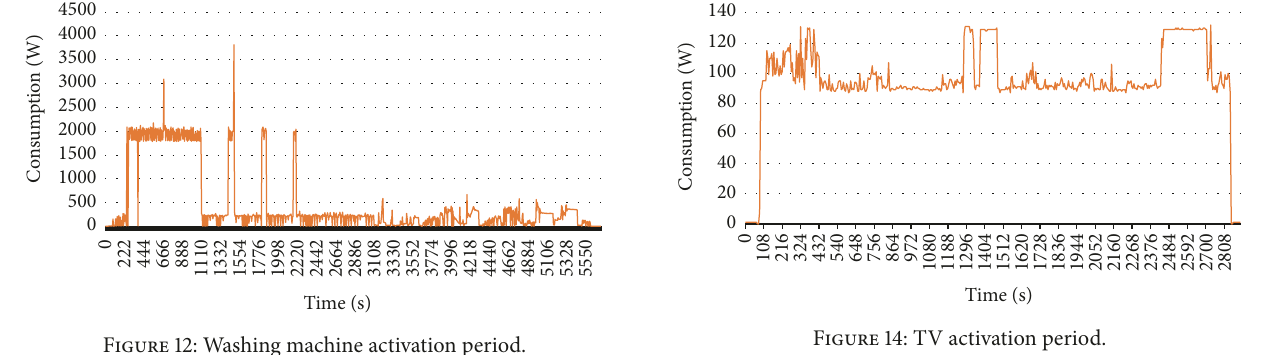
Figure 12: Washing machine activation period.